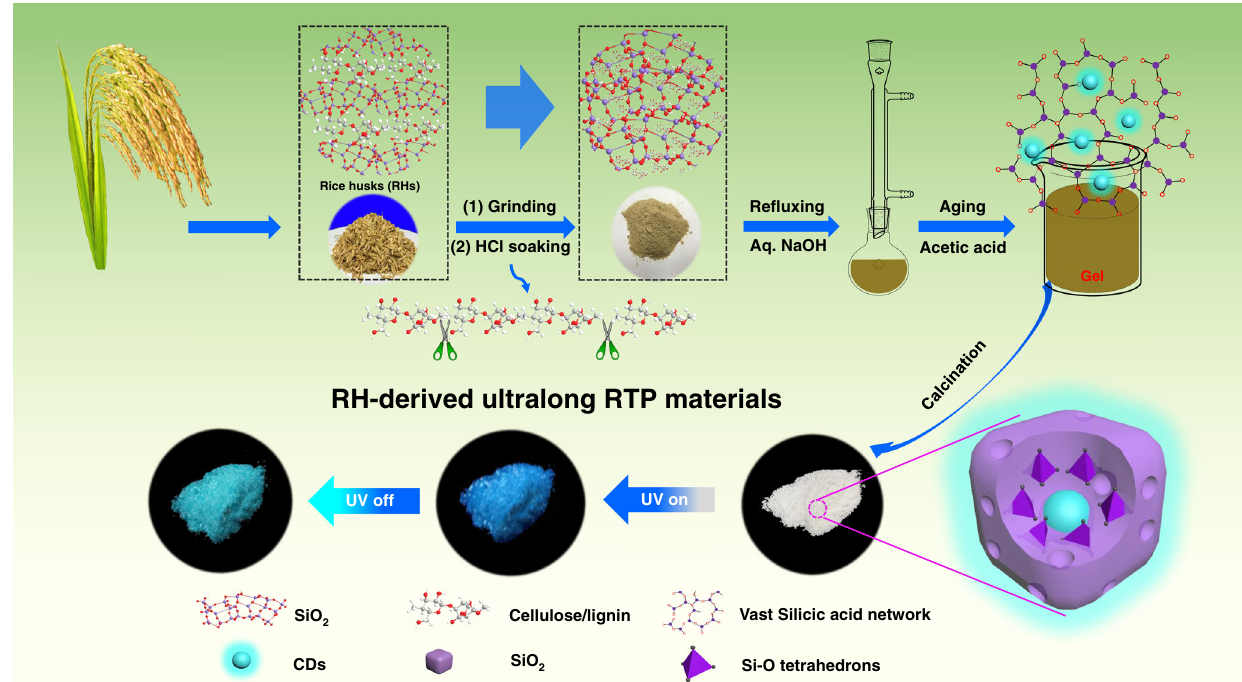
Fig. 2 Design of multi-con fi ned CDs@SiO 2 . Schematic of the overall process for fabrication of the metal-free CDs@SiO 2 RTP materials with ultralong lifetime from rice husks